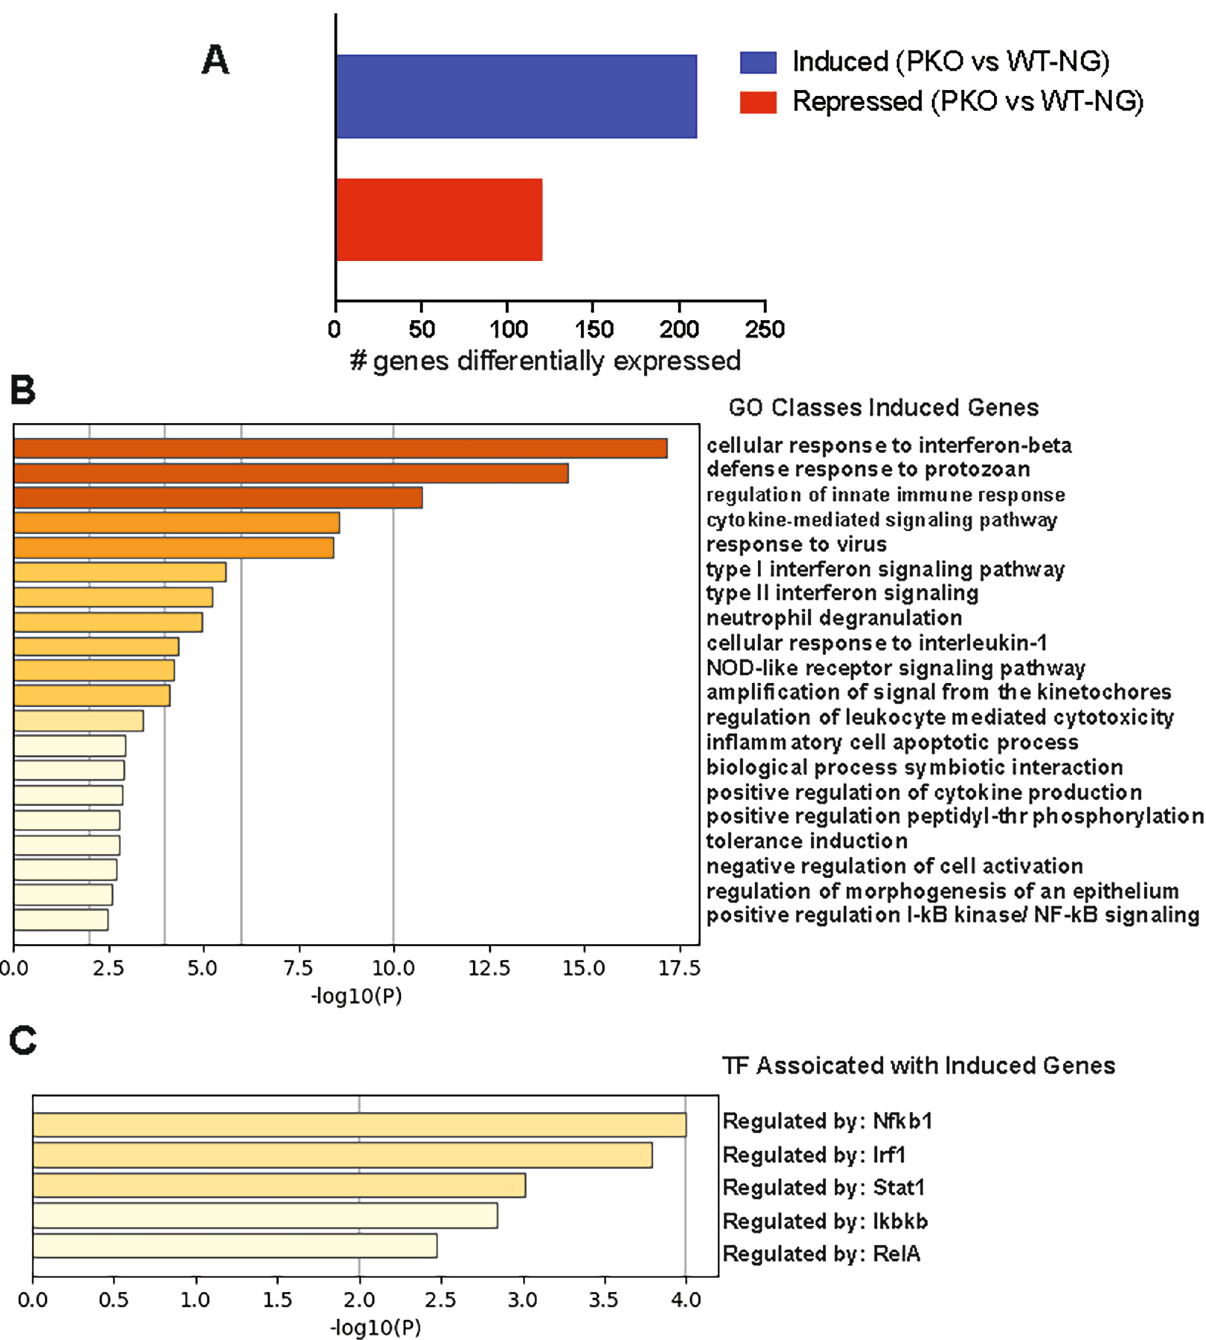
Figure 3. GO classes and transcription factors associated with genes upregulated in Ldlr −/− :Prmt2 −/− plaque CD68+ cells under normoglycemic conditions. ( A ) PRMT2 deficiency in plaque CD68+ cells resulted in the upregulation of 204 and downregulation of 120 genes (logFC < 2.0, P < 0.01). ( B ) Metascape analysis of pathways for genes up-regulated in Ldlr −/− :Prmt2 −/− reveals genes involved in cytokine signaling and innate immune/ inflammatory responses. ( C ) Transcription factors associated with the genes upregulated in Ldlr −/− :Prmt2 −/− in normoglycemia include the prototypical proinflammatory transcriptional regulatory factors NF-kappa B, IRF1, and